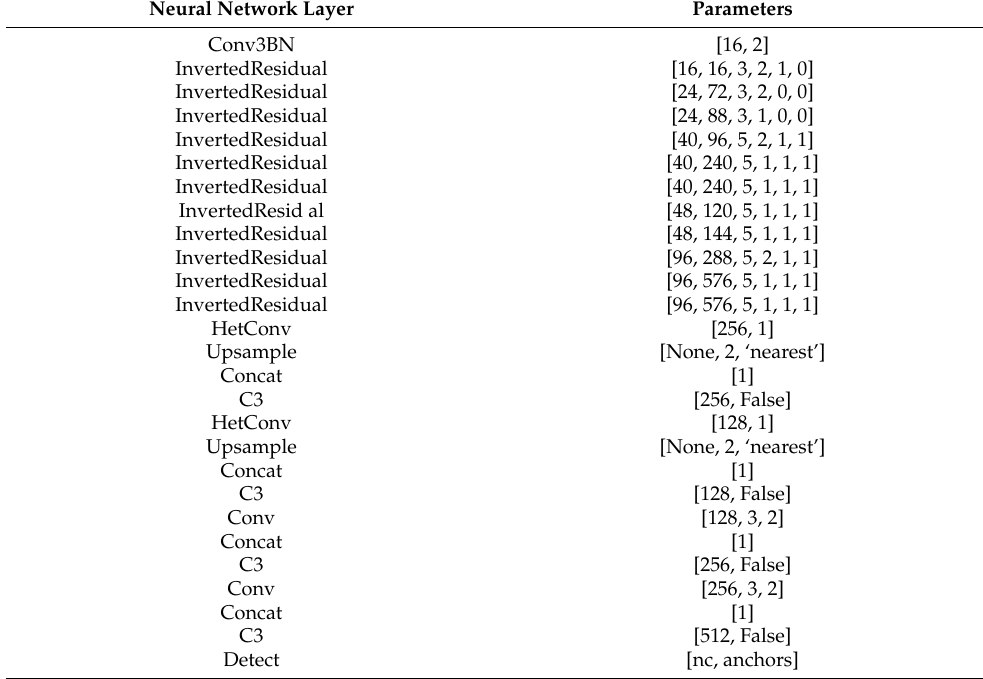
Table 1. Improved network parameter Table 1. improved network parameter settings.